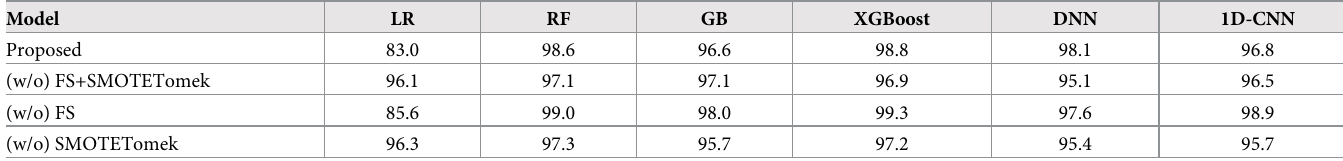
Table 9. Ablation experiments of the proposed method (accuracy comparison).